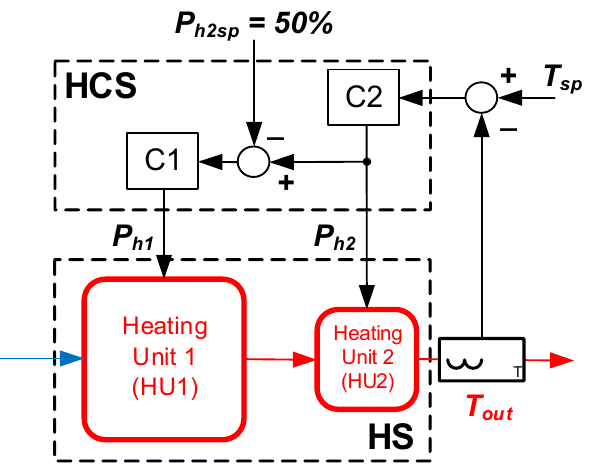
Figure 3. Schematic diagram of the proposed HCS that consists of two controllers (C1 and C2) operated in the habituating control structure.